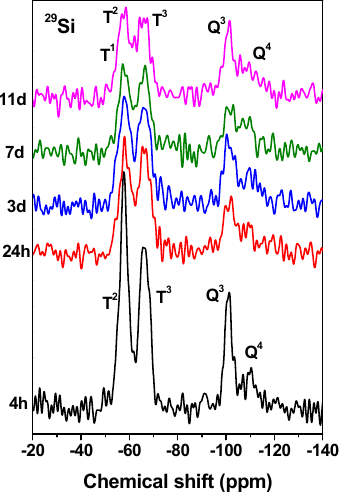
Figure 5. 29 Si MAS NMR spectra for the polysiloxane hybrids synthesized from [TMOS]/[MPTS] mixture at 65 °C for different times.